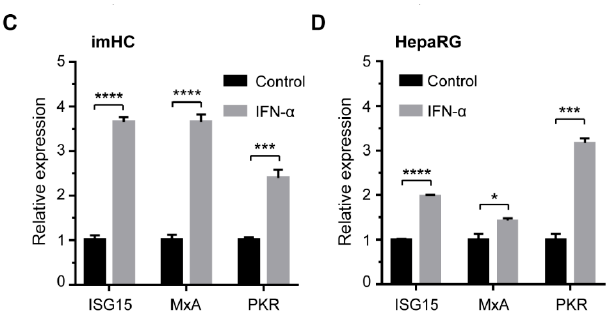
Figure 6. The reduction of HBV cccDNA and the upregulation of antiviral signaling in infected hepatocytes after the treatment with interferon- γ (IFN- γ ) and interferon- α (IFN- α ), respectively. Mature imHC and HepaRG were infected with HBV and treated with DAAs as well as IFN- γ . The relative cccDNA level in imHC in response to DAAs and IFN- γ was measured and normalized with PRNP in imHC ( A ) and in HepaRG ( B ). The upregulation of antiviral signaling genes (interferon-stimulated gene 15 (ISG15), human myxovirus resistance protein 1 (MxA) and protein kinase R (PKR)) in response to IFN- α treatment were monitored in imHC ( C ) and HepaRG ( D ). Data are represented as mean ± SD. *, **, *** and **** represented statistical different data with a p -value < 0.05, < 0.01, < 0.001 and < 0.0001 respectively.